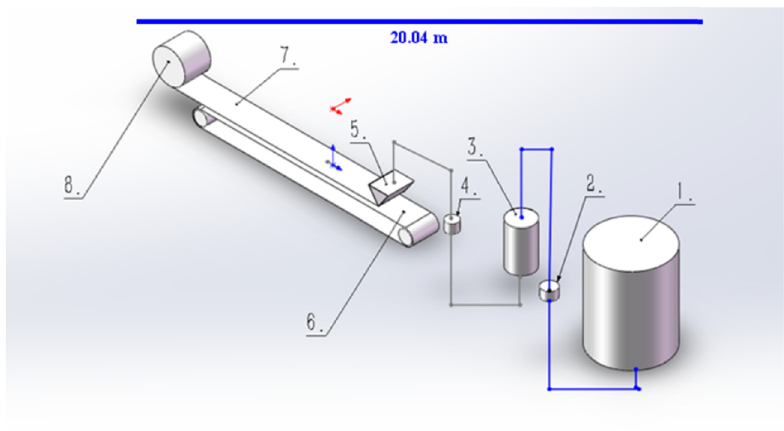
Figure 3: Fabrication machine for basic fl exible conductive PVA - CF: ( 1 ) mixer drum for mixing and blending of PVA, CF, and glycerin; ( 2 and 4 ) pump; ( 3 ) vacuum cavitation cylinder; ( 5 ) horizontal slit funnel; ( 6 ) heated conveyor steel belt; ( 7 ) PVA - CF fi lm; and ( 8 ) winding machine.